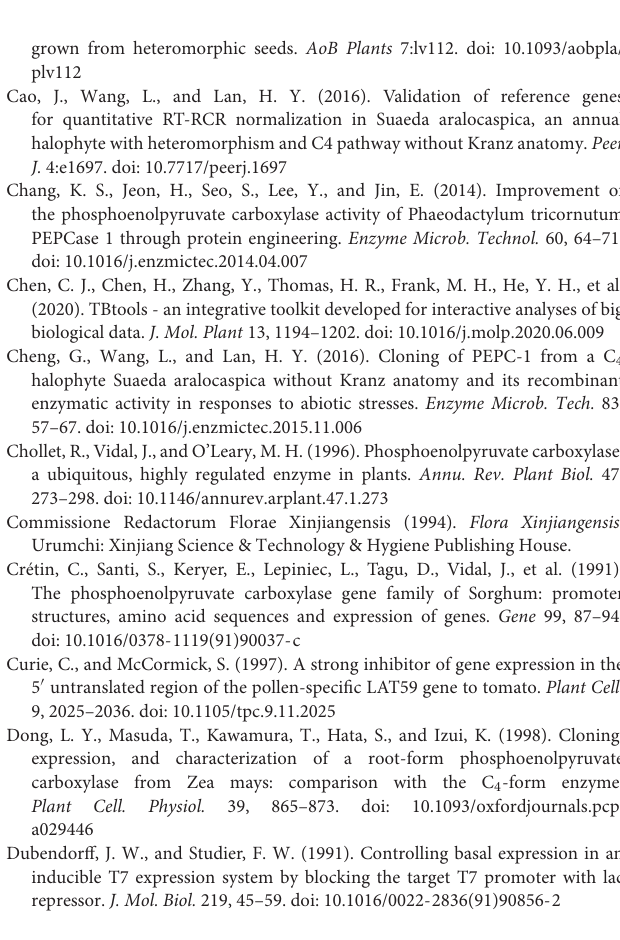
DNA; (B,D) Secondary structure of RNA. The free energy ( (cid:49) G ) of respective structure is shown. Supplementary Figure 6 | Ectopic expression of SaPEPC-1 and SaPEPC-2 in Escherichia coli and the immunoblotting analysis. (A) Sodium dodecyl sulfate–polyacrylamide gel electrophoresis (SDS-PAGE) analysis of recombinant SaPEPC proteins; (B) Immunoblotting analysis of the recombinant SaPEPC proteins with anti-His antibody. NI, non-induced total protein; Total, total crude protein; Sol, soluble protein; Ins, insoluble protein; lane M1, protein molecular weight (MW) marker; and lane M2, prestained protein MW marker. The arrowhead indicates the specific protein band of approximately 110 kDa corresponding to PEPC derivatives. Supplementary Figure 7 | Time courses of the growth of SaPEPC-1 (I) and SaPEPC-2 (II) recombinant strains under different abiotic stresses. (A,A (cid:48) ) Non-stressed condition; (B,B (cid:48) ) 400 mmol · L − 1 NaCl; (C,C (cid:48) ) 10% PEG; (D,D (cid:48) ) 25 ◦ C (30 ◦ C for SaPEPC-2 ); (E,E (cid:48) ) 75 µ mol · L − 1 methyl viologen (MV); and (F,F (cid:48) ) pH 5.0. The culture was sampled at an interval of 2 h to a total of 12 h. Values are means ± SD of three replicate. Supplementary Figure 8 | Growth and enzyme activity of recombinant SaPEPC strains under temperature and MV treatments for 12 h. (A) Growth of recombinant SaPEPC-1 and SaPEPC-2 strains under different temperatures. (B) Enzyme activity of recombinant SaPEPC-1 and SaPEPC-2 strains under MV stress. *, ***, ****: Indicate a significant difference between control strain and recombinant SaPEPC strains at the same temperature at 0.05, 0.001, 0.0001 level, respectively. Different lowercase letters indicate significant differences between control and stress treatment at different MV concentrations. Values are means ± SD of three